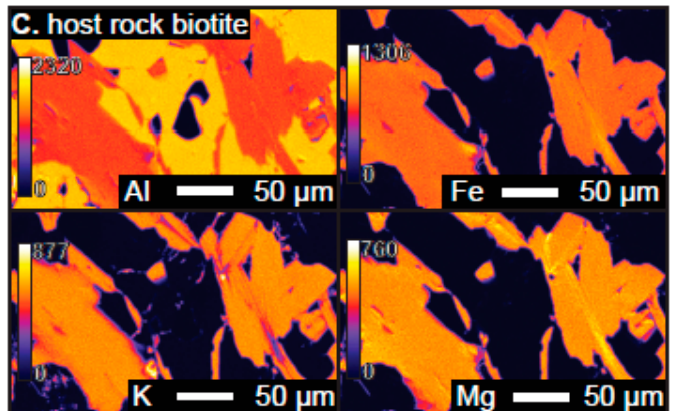
Figure 5. WDS chemical oxide maps of the three mineralized biotite types with an amphibolite facies metamorphic grade: ( A ) vein biotite from a pre- to syn-D 2 vein within an amphibolite facies meta-volcanic sample (MV-02); ( B ) halo biotite at the margins of a pre- to syn-D 2 vein within an amphibolite facies meta-volcanic sample (MV-02); and ( C ) host rock biotite within an amphibolite facies biotite schist sample (FW-11). Warm colours are higher elemental concentrations; cool colours are lower elemental concentrations. Note, colour-scales show elemental counts and are individually adjusted for each map to best visualize chemical heterogeneities. Chemical maps from all mineralized biotite types reveal homogeneous compositions with slightly Fe-rich and K-poor cleavage planes, with the exception of halo biotite revealing bands of a Ca-Al rich and Fe-Mg-K poor mineral phase within the biotite crystals.